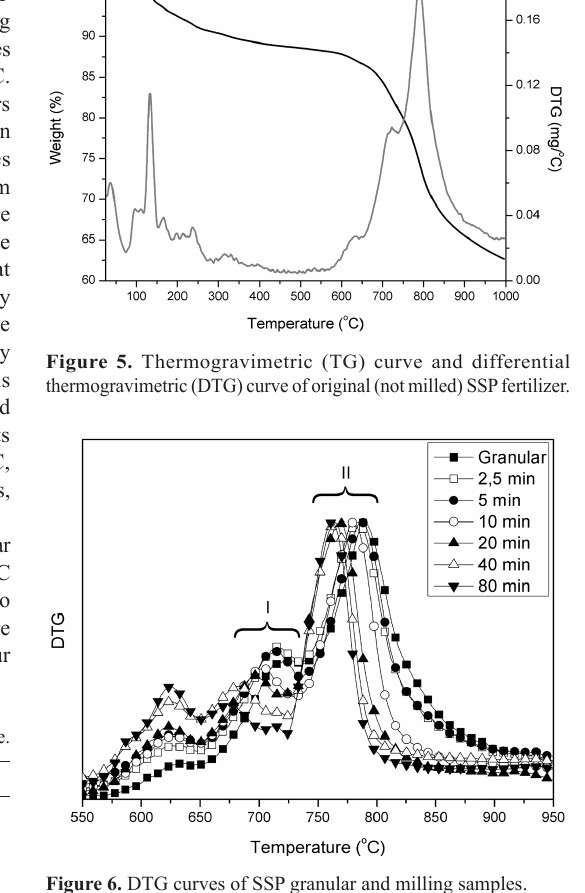
Figure 6. DTG curves of SSP granular and milling samples.